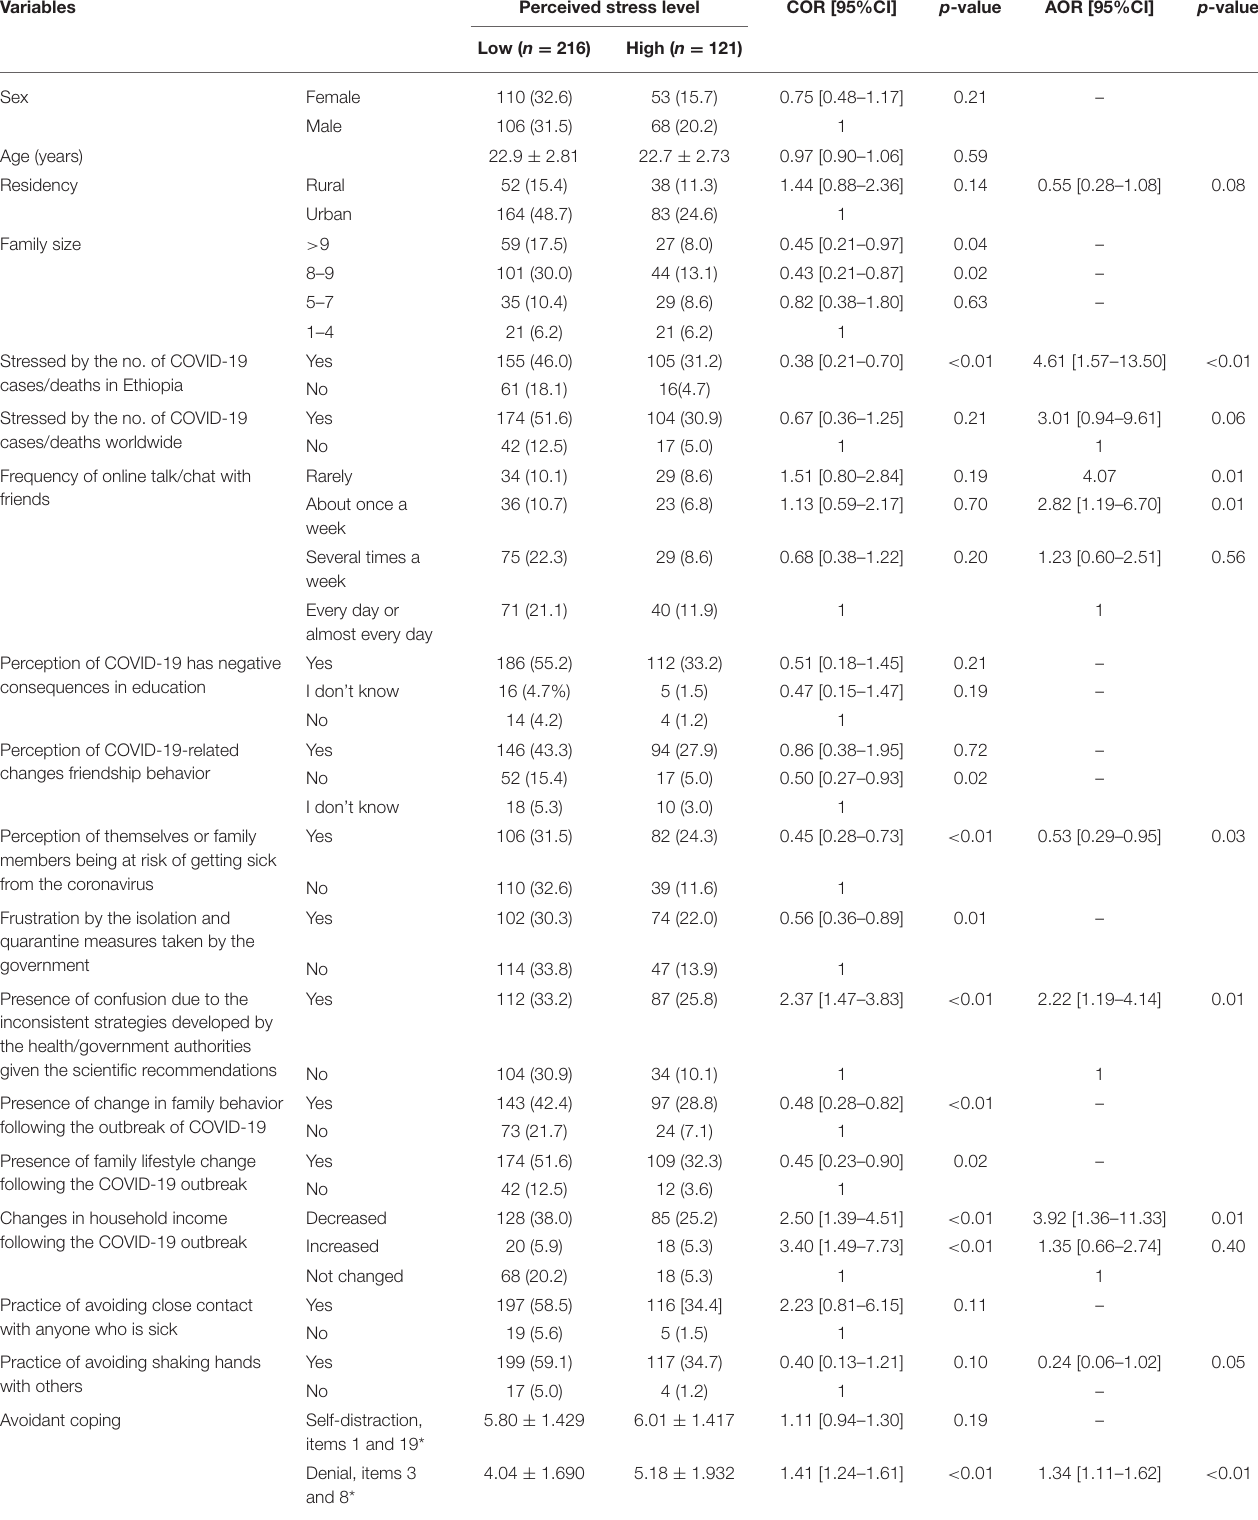
TABLE 6 | Bivariate and multivariate analysis to identify factors associated with perceived stress level.